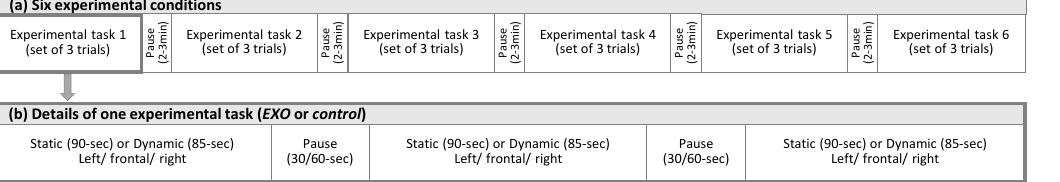
Figure 1. ( a ) shows the sequence of the six experimental conditions; two static and four dynamic: Static-EXO; Static-Control; Dynamic-EXO-Stoop; Dynamic-Control-Stoop; Dynamic-EXO-Squat; Dynamic-Control-Squat. The six conditions were performed in randomized order, and each was performed in a set of three Trunk orientations. Each set of static sorting tasks lasted 330 s, and each set of dynamic lifting tasks lasted 375 s. ( b ) shows one set of one experimental task. Trunk orientations ( left/frontal/right ) were performed in randomized order. Figure modified after Bär et al. (2022) [16]. The experimental tasks were performed while standing on a force plate in front of a table that was adjustable according to the subject’s height . The feet position was defined prior to the experiment and kept constant during each task by using markings on the force plate (Figure 2). The feet position was defined while the subjects were instructed to stand comfortably upright with their feet positioned evenly and facing straight ahead. The distance to and height of the table was adjusted to allow the subject to perform the sorting or lifting task in the required body postures (explanation below). The six experimental conditions were performed in sets of three trials, with each trial performed in one of the three trunk orientations. Therefore, the sorting or the lifting box was placed to the front, in a 45° rotation to the left, or in a 45° rotation to the right from the sagittal plane. Reported results in the frontal direction include both knees when the work tasks were performed without trunk rotation. The reported ipsilateral results refer to both trunk orientations (left and right), including the knee belonging to the body side that coincides with the direction of trunk orientation. The reported contralateral results refer to both trunk orientations (left and right), including the knee belonging to the side of the body opposite to the direction of trunk orientation. Figure 2. Force plate prepared with a coordinate system and with the individually pre-adjusted and pre-marked foot positions for the different tasks (static and dynamic). Marked landmarks were the heel in line with the Achilles tendon, medial and lateral malleolus, medial and lateral sesamoid, and the forefoot. Tape was placed on the subjects’ shoes and on the force plate, and a connecting line was drawn between each pair of foot-to-floor tape markings considering the above outlined landmark positions. The malleolus markers were later used to determine the x and y coordinates of the ankle joint centers for both feet; by calculating the midpoints of the lateral and the medial malleoli.